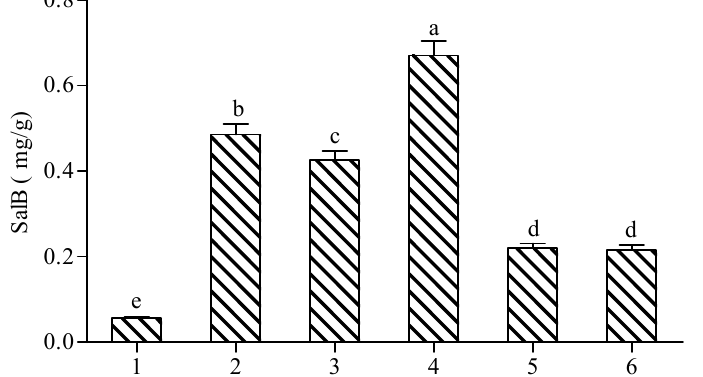
Figure 5. Effects of different treatments on the production of Sal B in Salvia miltiorrhiza cell cultures. 1: control (H H O + DMYU + IMD; 6: H 2 2